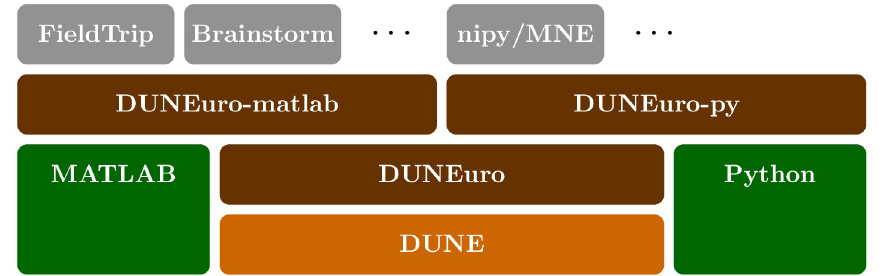
Fig 3. Modular structure. Relation of the DUNEuro modules with respect to DUNE, external software and downstream